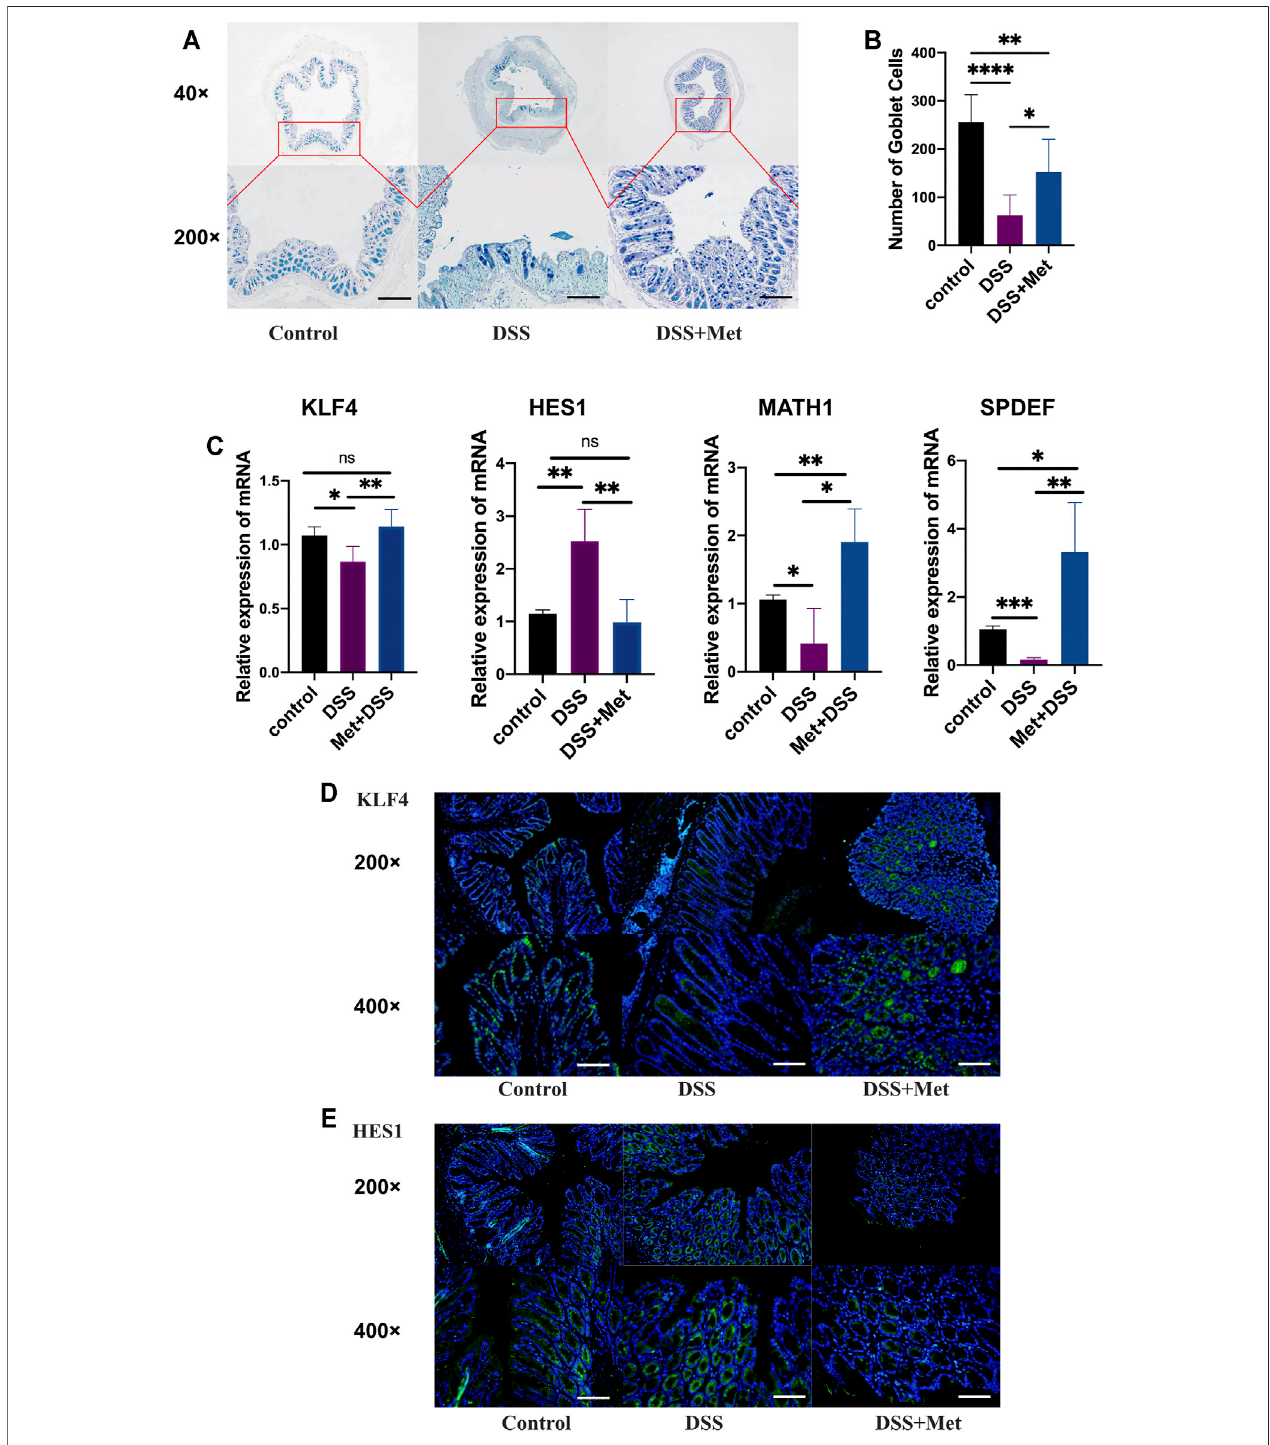
FIGURE 3 | Metformin positively regulates the differentiation of goblet cells. Alcian blue-periodic acid-Shiff (AB-PAS) staining of colon tissue (scale bars, 400 μ m) ( n (cid:1) 4 – 7) (A) andcountofgobletcells( n (cid:1) 4 – 7) (B) ,RT-qPCRassay( n (cid:1) 3 – 6)ofKruppel-like factor4(KLF4),hairyand enhancerofsplittype-1(HES1),MATH1andSAM pointed domain containing ETS transcription factor (SPDEF) at the mRNA level (C) , immuno fl uorescence assay of Klf4 (scale bars, 200 m) ( n (cid:1) 4) (D) and Hes1 (scale bars, 200 μ m) ( n (cid:1) 4) (E) protein detection in the mouse colon and statistical comparison was made using an ANOVA test followed by Tukey-Kramer post-hoc tests. * p < 0.05, ** p < 0.01, *** p < 0.001.